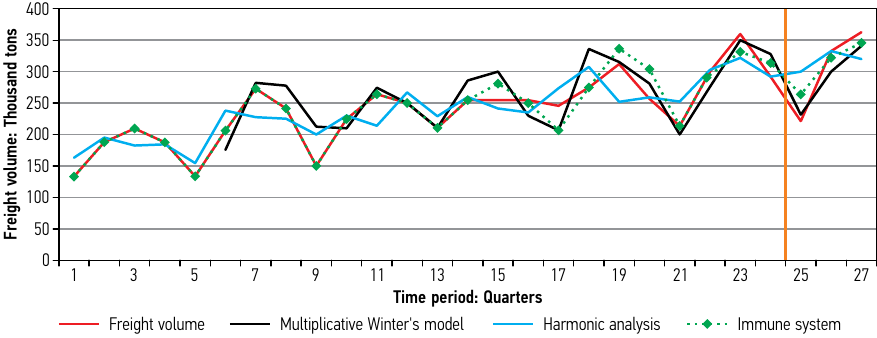
Fig. 4. Graphical presentation of forecasting